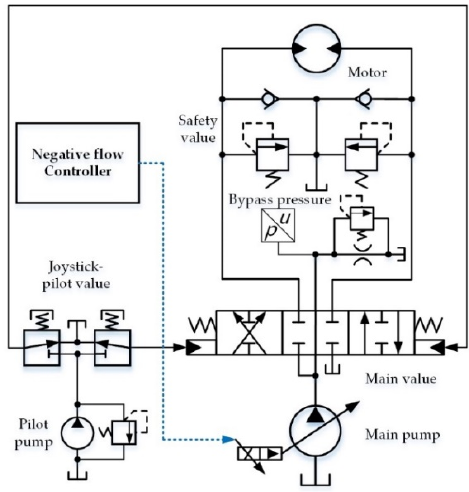
Figure 1. Hydraulic schematic of the original negative control swing system.